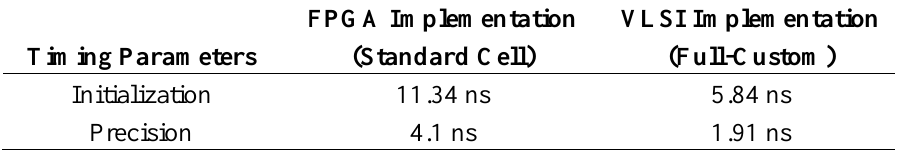
Table 2. Comparison between FPGA and VLSI implementations, considering timing